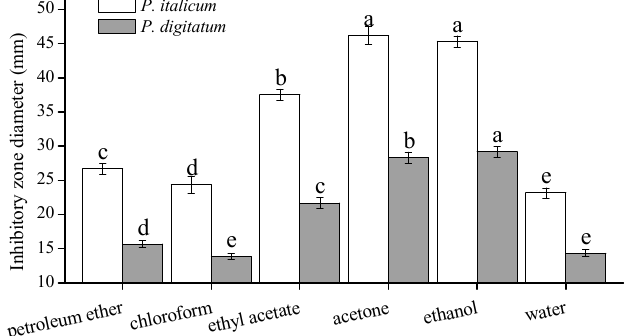
Figure 1. The effects of different extraction solvents on DIZs against P. italicum and The vertical bars represent the standard deviation ( n = 3). a ´ e Significant differences at p < 0.05 level. P. digitatum . The vertical bars represent the standard deviation ( n = 3). a–e Significant Extraction conditions under ultrasonic-assisted extraction: 60 min extraction time, 20:1 solvent to solid differences at p < 0.05 level. Extraction conditions under ultrasonic-assisted extraction: ratio and 20 ˝ C temperature. 60 min extraction time, 20:1 solvent to solid ratio and 20 °C temperature.